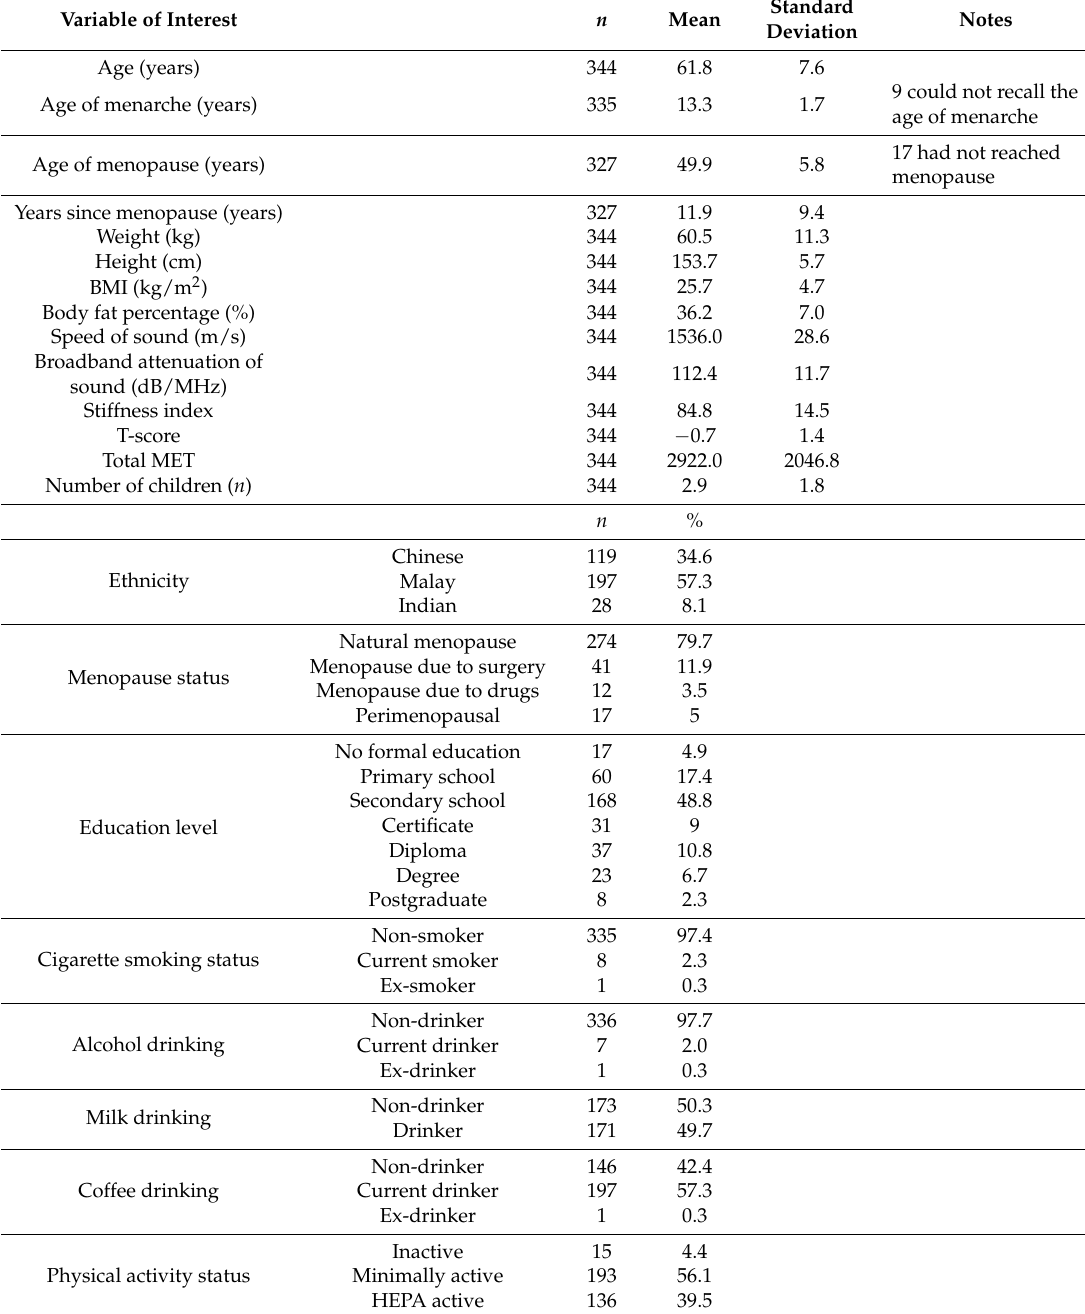
Table 1. Characteristics of the